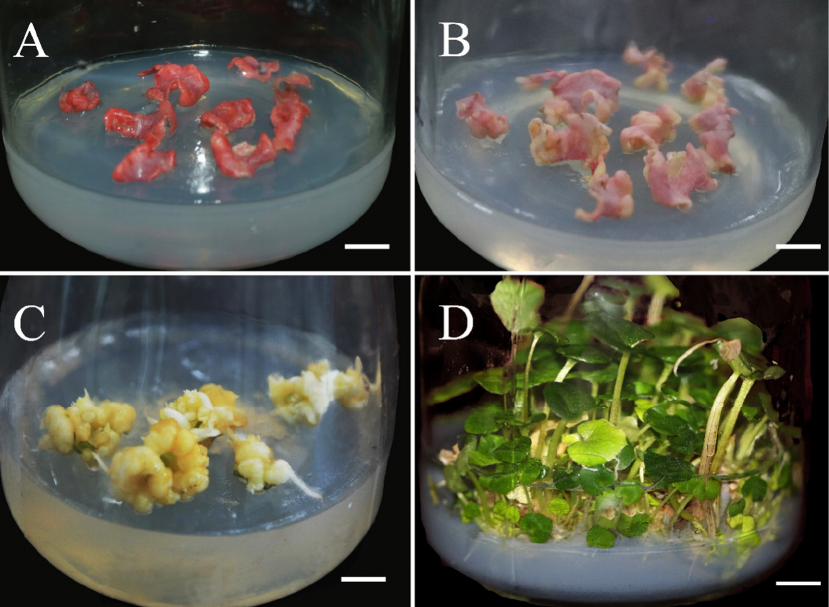
Figure 1. In vitro plant regeneration from leaf segments of two aneuploids of ‘Red Flash’ caladium ( Caladium × hortulanum Birdsey), namely, the SVT9 and the SVT14. ( A ) Leaf segments of the SVT9 cultured on MS basal medium supplemented with 0.5 mg·L − 1 NAA and 1.0 mg·L − 1 6-BA for 10 days; ( B ) initiated callus from the edge of the excised leaf pieces of the SVT14 after one month of culture; ( C ) shoots or roots regenerated from the excised leaf pieces of the SVT9 after 3 months’ culture; ( D ) plantlets regenerated from the excised leaf pieces of the SVT9 after 5 months’ culture. Bars = 1 cm.